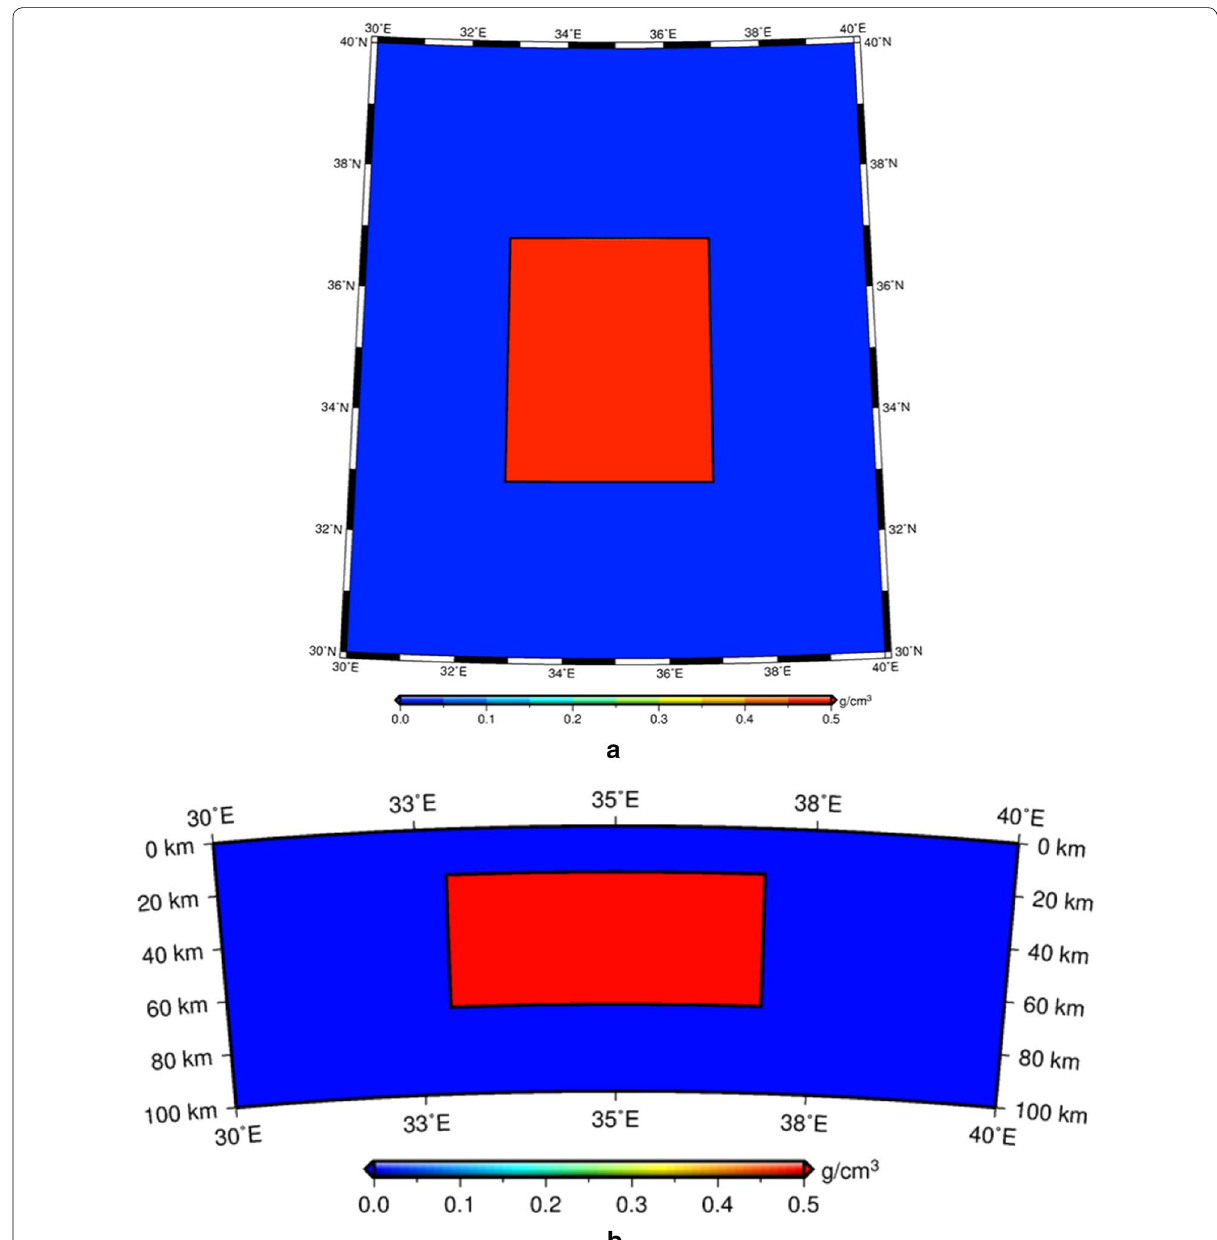
Fig. 2 Artificial synthetic model ( a horizontal spherical prism body). a Horizontal slice of the model with a radial length of 1698 km, b vertical profile of the model with latitude of